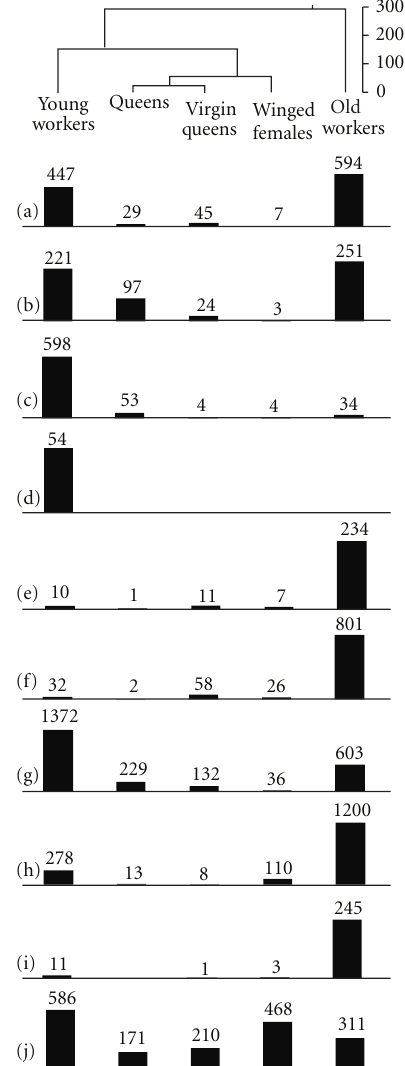
Figure 2: Dissimilarity dendrogram of individuals of P. striata showing the division of labor by age. Behavioral categories: (a) feeding, (b) communication, (c) brood care, (d) sexuate care, (e) defense, (f) exploring and foraging, (g) grooming, (h) inactivity, (i) dominance, and (j) nest